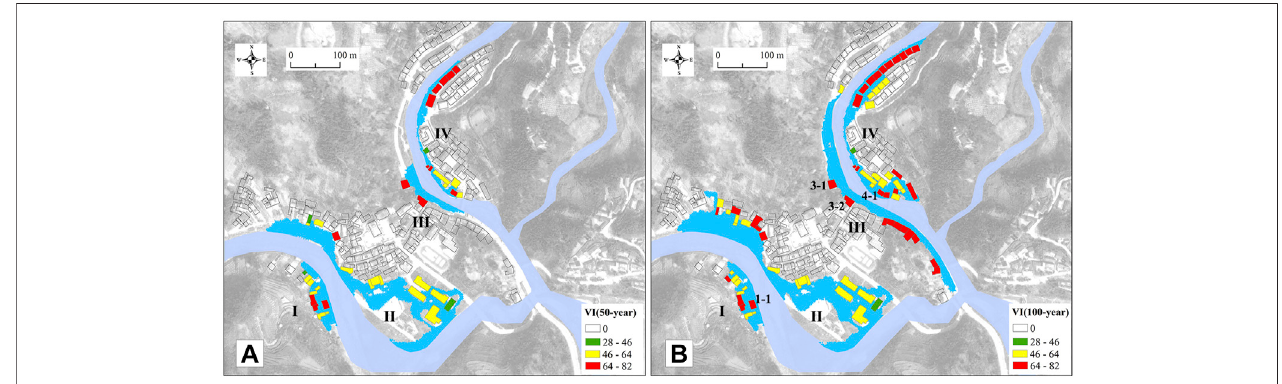
FIGURE 11 | Distribution of VI in fl ood scenarios with (A) 50-year and (B) 100-year R T .